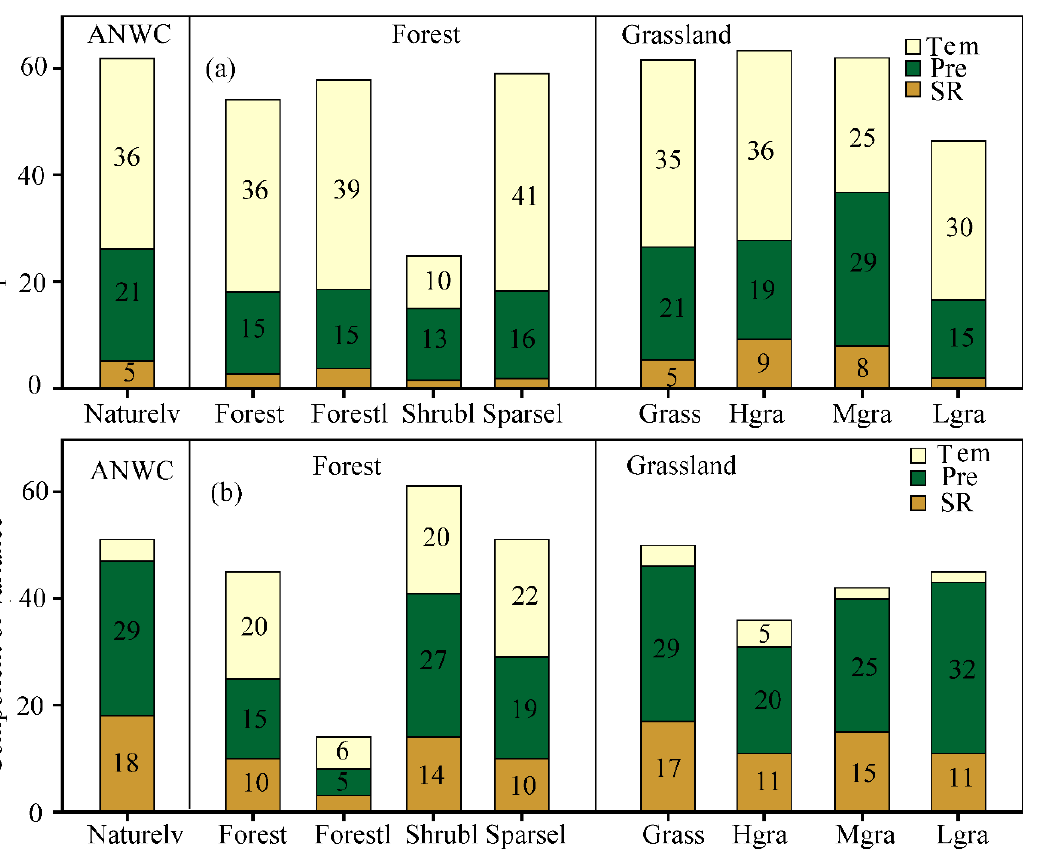
Figure 9. Variance partitions of the climate variables derived through the Hierarchical Partitioning Algorithm (HPA) (( a ): contribution rate for regional changes in the Normalized Difference Vegetation Index (NDVI) during the growing season; ( b ): contribution rate for spatial distribution of mean NDVI during the growing season).